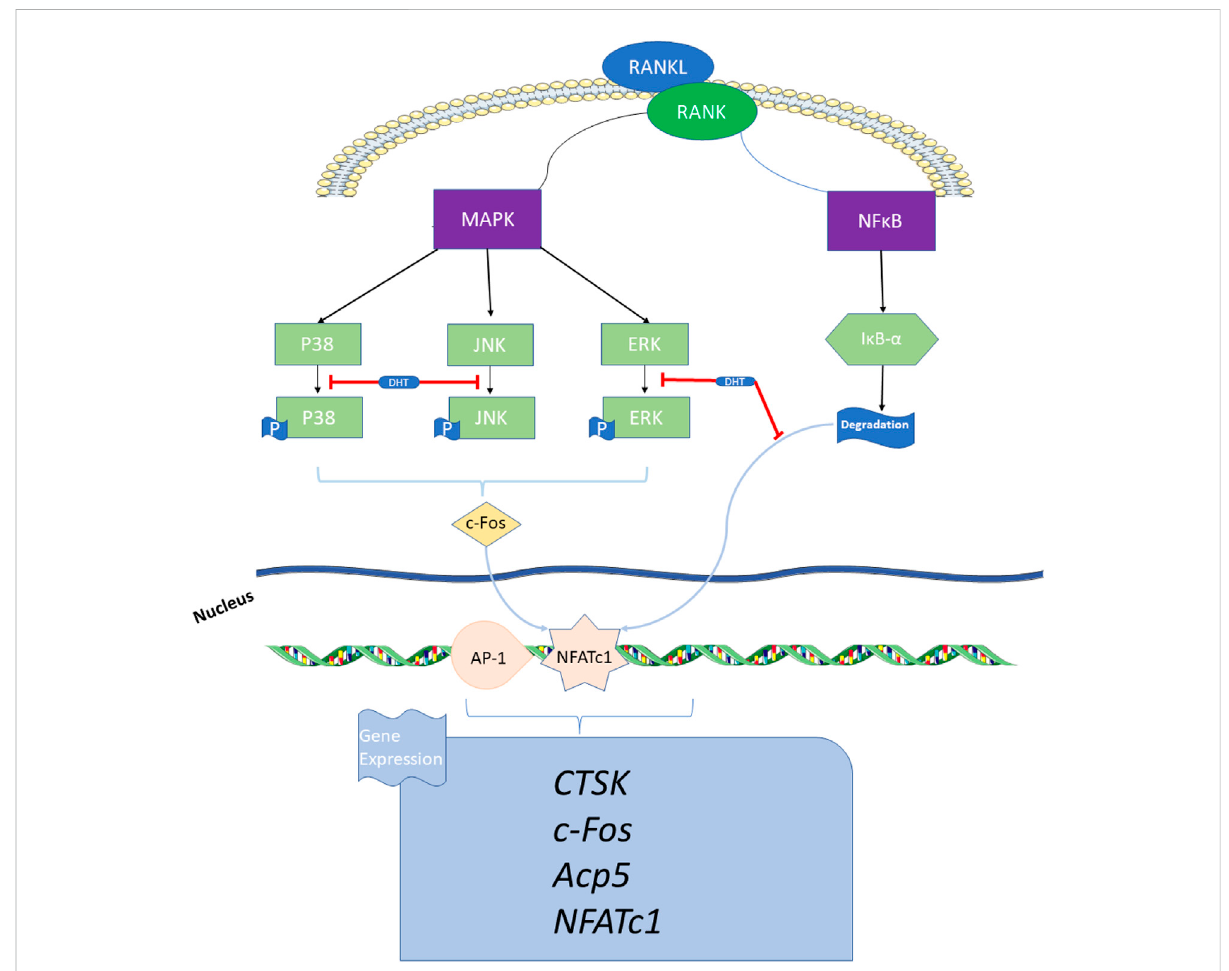
FIGURE 9 Schematic indicating the mechanism by which DHT inhibits osteoclast formation. DHT inhibits RANKL-induced osteoclast differentiation via the MAPK and NF- κ B signaling pathways, thereby decreasing the expression of related genes and proteins, such as NFATc1, Acp5, c-Fos, and CTSK that affect osteoclast bone